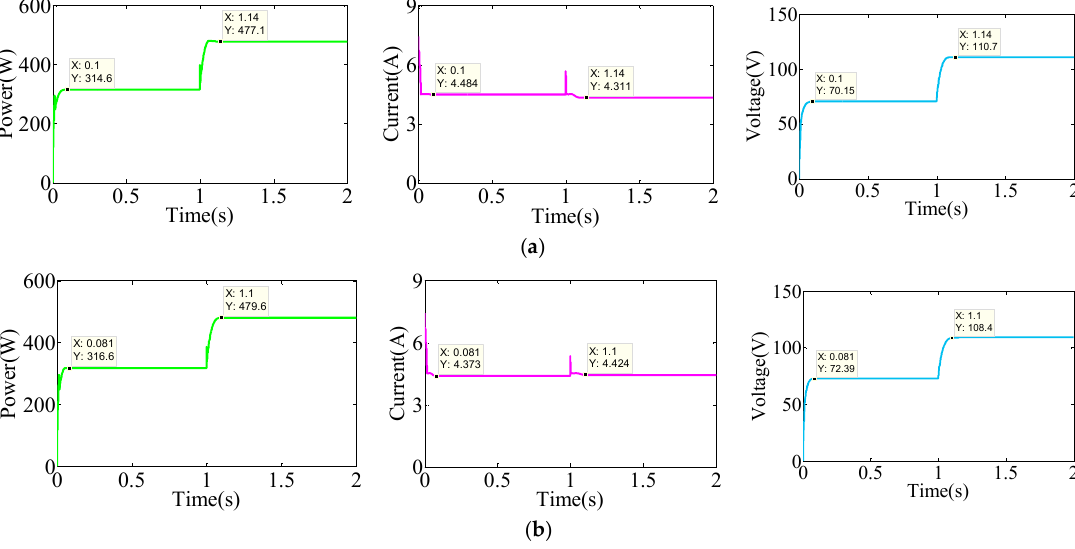
( a ) ( b ) Figure 12. Power, current and voltage tracking curves of FPA and MFPA from weak shading to strong shading ( a ) FPA; ( b ) MFPA. 5.3. Variable Temperature Conditions In this case, irradiation is always stabilized in 1000 W/m 2 and the temperature of the PV system is varied after 1 s. For experiment the situation, the PV array configuration is analogous as shown in Figure 6. The output characteristics of the PV array for variable temperature is shown in Figure 13. It is obvious that the PV system has only one peak when the temperature applied the system is non- uniform. Initial temperatures are set to 75 °C, 50 °C and 25 °C, and uniform temperature as 20 °C is exploited after 1 s. At the two stages, the global peaks are arranged at 647 W and 736.5 W, respectively. Throughout the tracking process, both MFPA and FPA have tracked the global maximum. However, the MFPA’s tracking result exhibits better robustness. It is noteworthy to mention that when the operating temperature of the PV system is decreased, the output power and voltage of the system increase, and the current drops slightly. Power, current and voltage tracking curves of FPA and MFPA for change temperature are shown as Figure 14. ( a ) ( b )